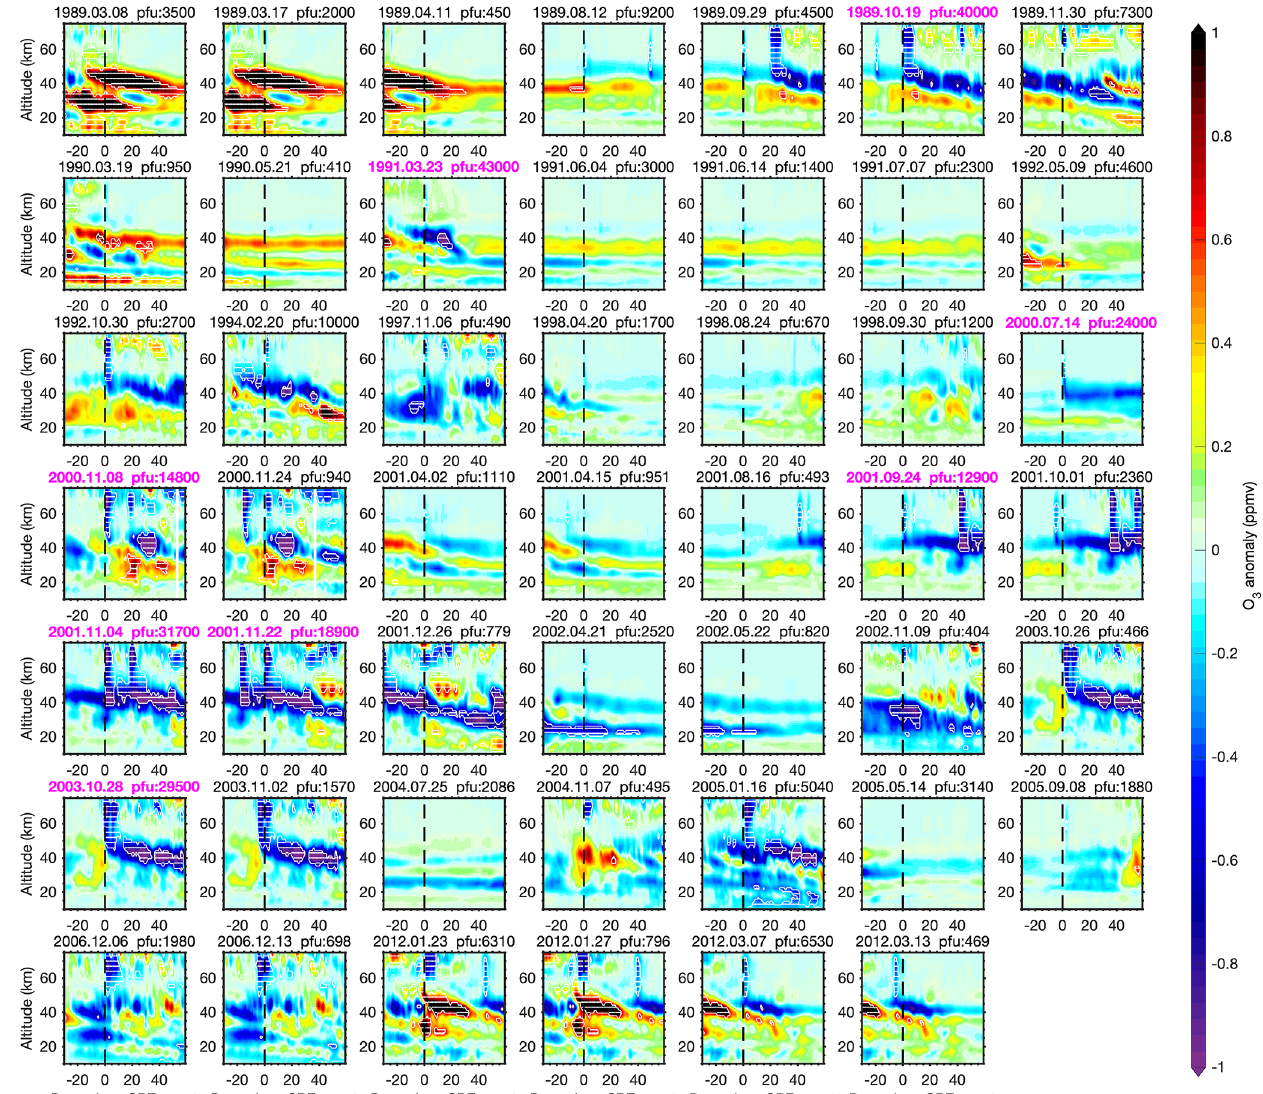
Figure 6. Same as Fig. 4 but for all simulated WACCM-D ozone anomalies (not only co-located with MLS measurement) before and after individual large SPEs (proton fluxes > 400pfu) since 1989. Extreme SPEs (proton fluxes > 10000pfu) are marked with bold magenta